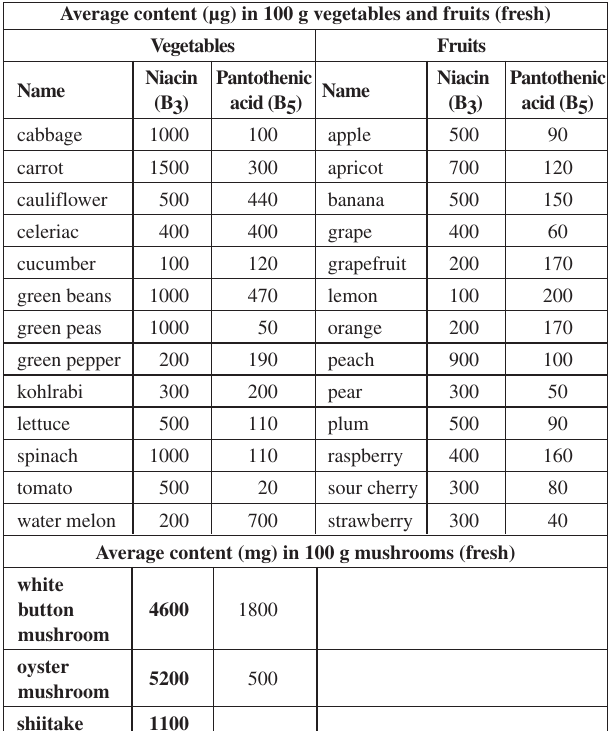
Table 6. Average niacin and pantothenic acid content (µg) in 100 g vegetables, fruits and mushrooms (fresh) Average content (µg) in 100 g vegetables and fruits (fresh) Vegetables Fruits